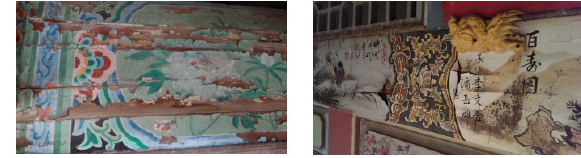
Figure 1. Painting was damaged by micro-climate change Most typical Taiwanese temples were built by wood and brick structure with 1 open façade (semi-open space), outdoor